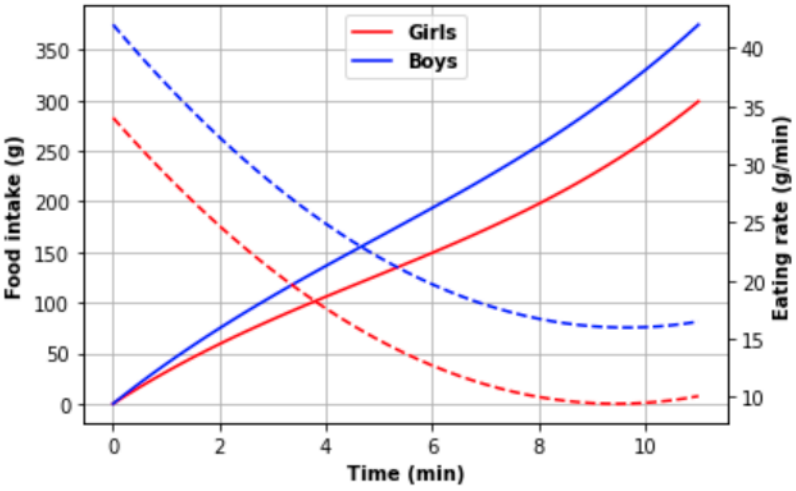
Figure 3. Combined diagram: solid line—food mass intake amount, dashed line—eating rate.